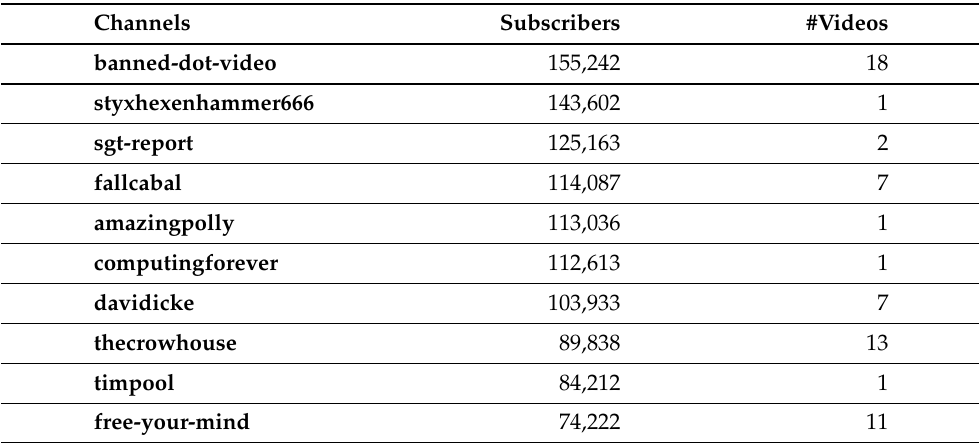
Table 5. Top 10 popular BitChute channels with their number of subscribers and the number of videos they shared from the collected dataset.